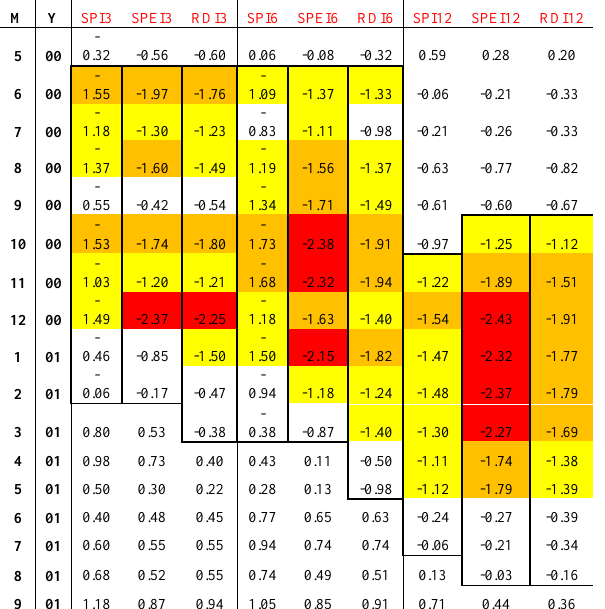
Table 5. The drought of 2000 for SPI, SPEI, and RDI. The bold boundaries enclose the drought